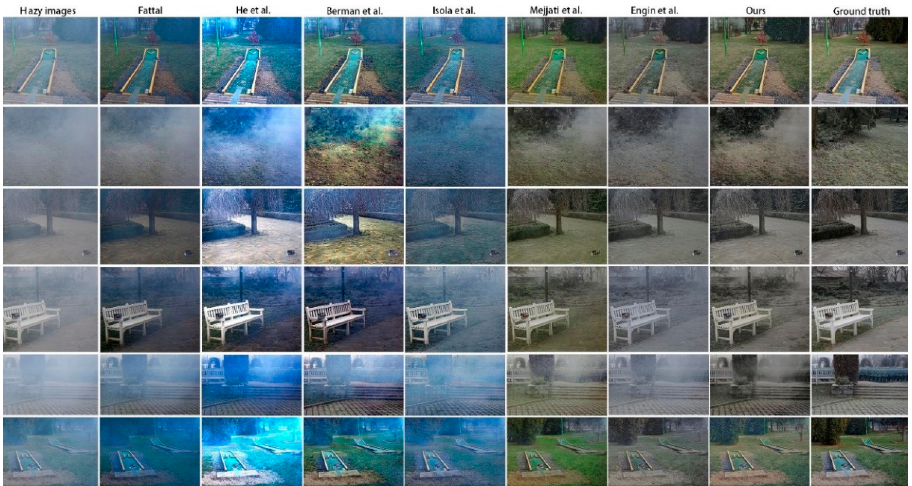
Figure 4. Dehazing results using the O-HAZE [10] dataset. The proposed method presented an